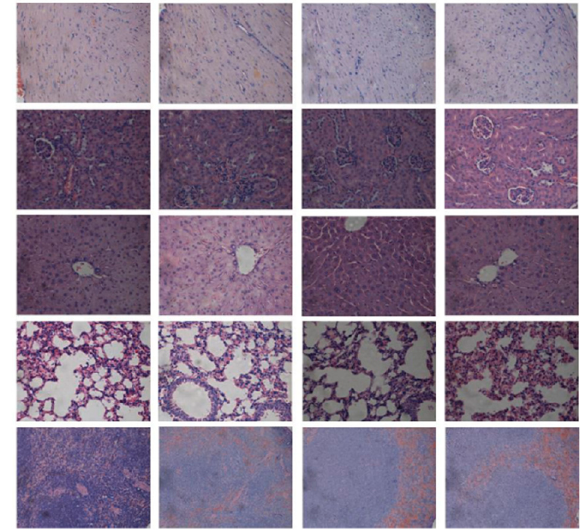
Figure A2. Pathology of major organs from treated mice (HES staining). Columns (from left to right): control, siRNA, AD , AD / siRNA. Rows (from to bottom): heart, kidney, liver, lung, spleen. Adapted from [6] with the permission of John Wiley and Sons, 2014.